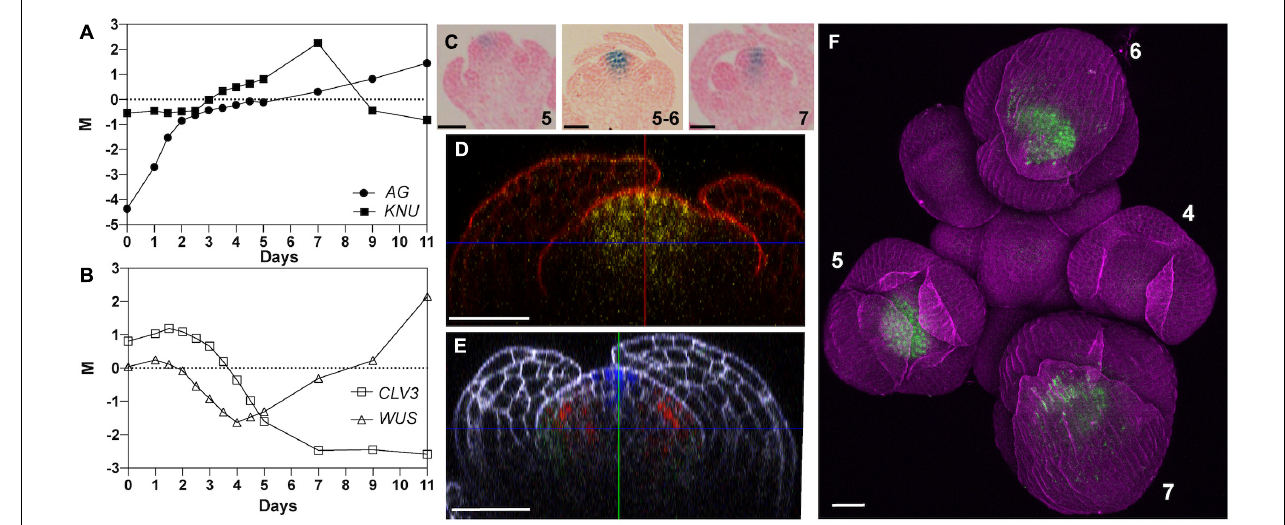
FIGURE 1 | Expression of KNU in early stage floral buds. (A,B) Temporal expression of (A) AG and KNU and (B) WUS and CLV3 during flower development. M values (log 2 of expression of a gene at a given time-point/expression of that gene in a common reference sample) are shown. Data from Ryan et al. (2015). (C) Activity of a pKNU::KNU-GUS reporter in early stage flowers. Approximate floral stages are indicated. (D) Confocal image of a pKNU::KNU-VENUS reporter in a stage 5 floral bud. A vertical optical section is shown. (E) Confocal image of gAP3-GFP (green), gSUP-3xVenusN7 (red), and pCLV3-dsRedN7 (blue) reporters in a stage 5 floral bud. A vertical optical section is shown. Compare the expression domain of CLV3 to that of KNU in (D) . (F) Confocal image of a pKNU::KNU-VENUS reporter in an inflorescence. Numbers indicate approximate floral stages. Scale bars: 20 µ m.